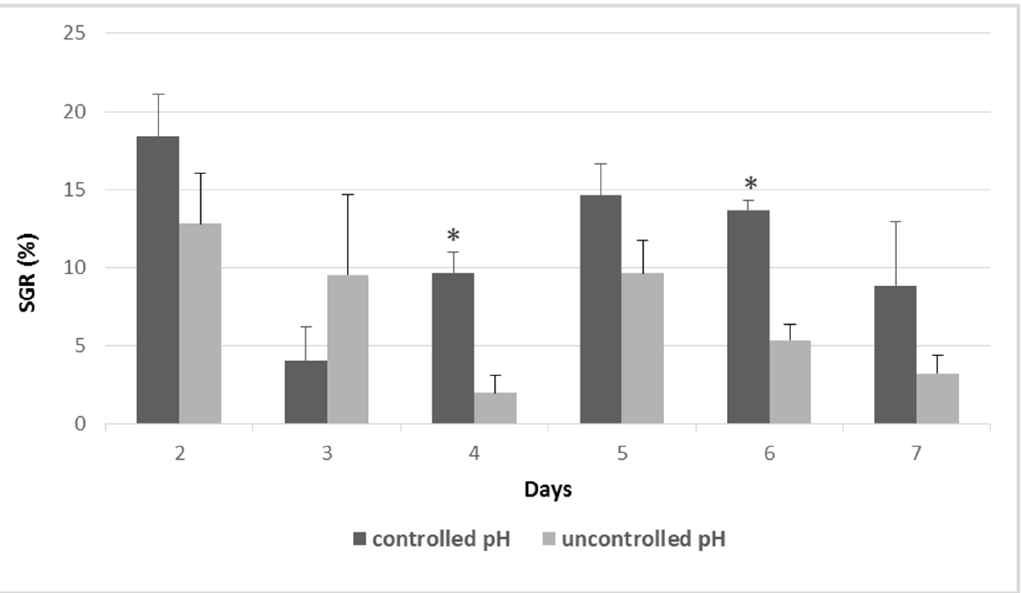
Figure 4. SGR and standard error in the different experimental conditions during the culture period. Statistically significant differences ( p < 0.05) are showed by asterisks (*).